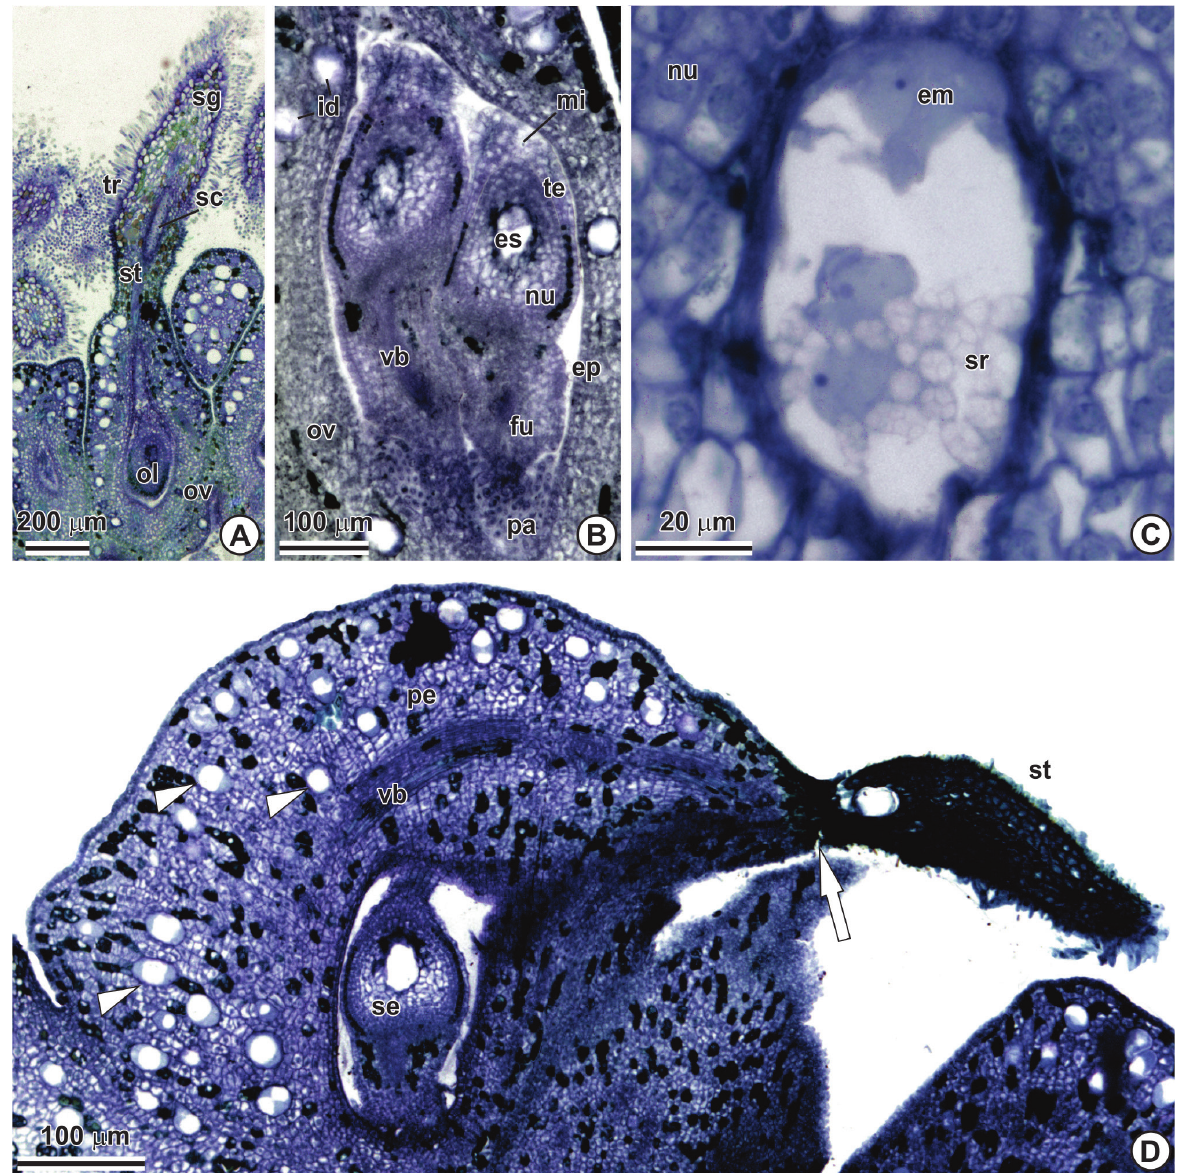
Figure 2 - Longitudinal sections of the gynoecium from an aspermic mutant of Annona squamosa . A flower carpel in pre-anthesis (A) and a detail of the ovary with two ovules (B) . An ovule, 24 h after pollination, showing the embryo sac (C) . The carpel, 48 h after pollination, showing the abscission zone of the style (arrow) and secretory idioblasts (arrowheads) (D) . em , embryo; es , embryo sac; fu , funiculus; id , secretory idioblast; ol , ovule; ov , ovary; mi , micropyle; nu, nucellus; pa , papillae; pe , pericarp; se , seed; sc , stylar channel; sg , stigma; sr , starch grain; st , style; te , integument; tr , trichomes; vb , vascular